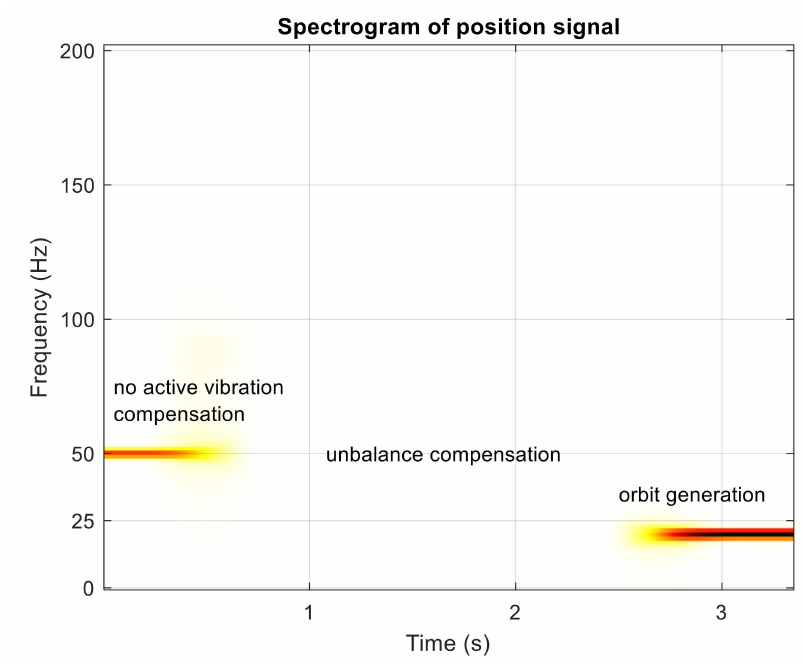
Figure 10. Spectrogram of simulated position signal in the x